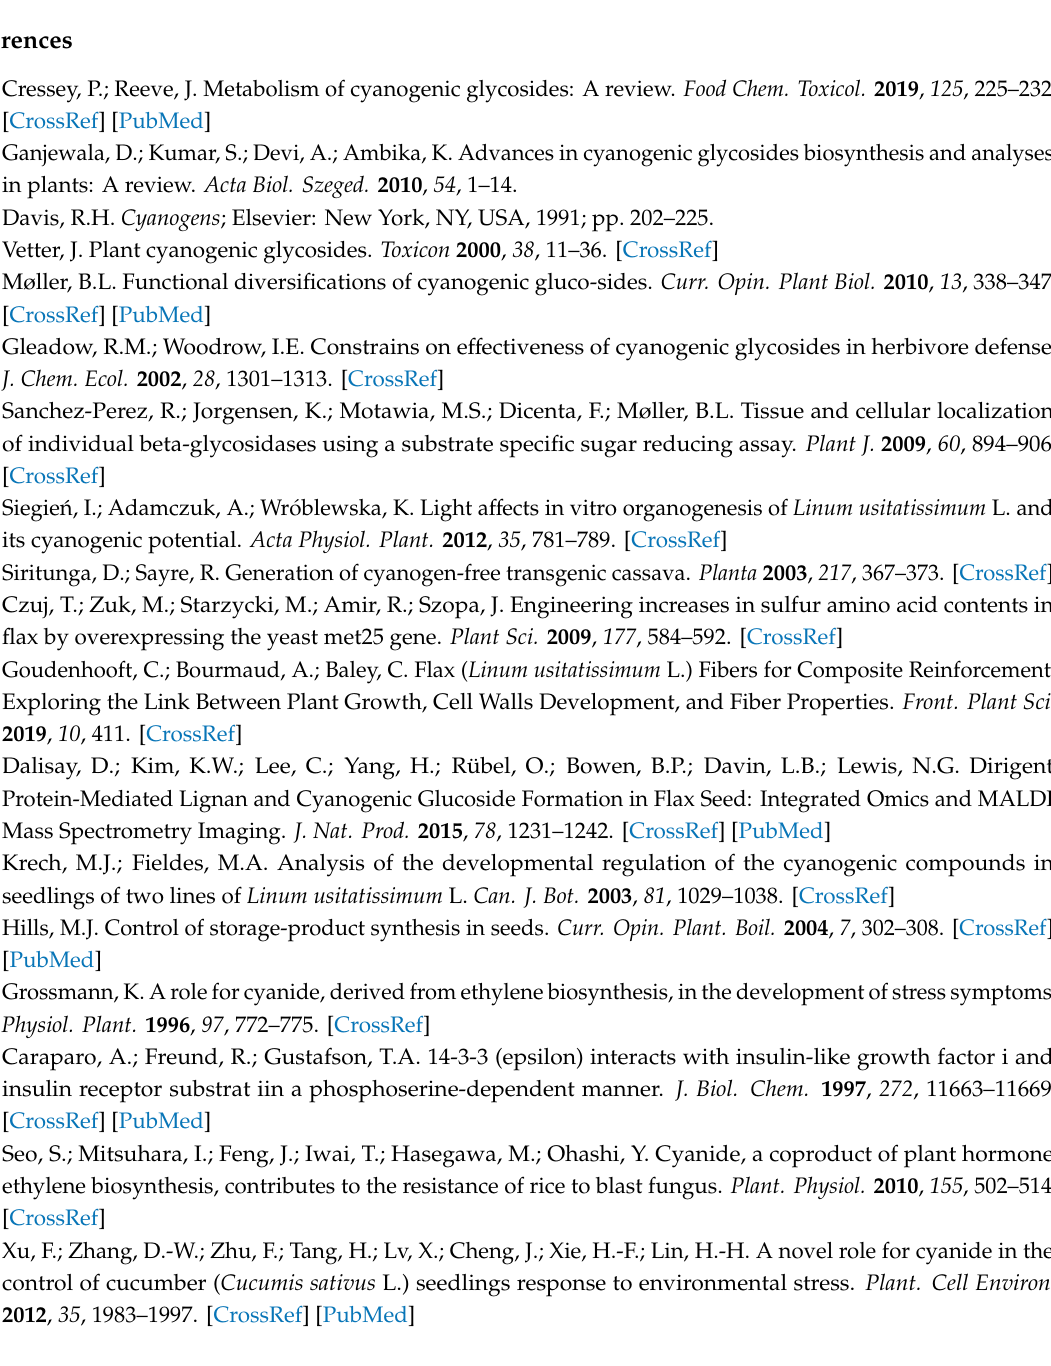
Table S1: Content of cyanogenic glycosides in flax tissues at successive stages of development of control plants (Linola) and those producing sulfur amino acids (Met25), Table S2: Activity of GC metabolism genes during plant growth in control and Met25 expressing plants, Table S3: Sequences of primers used in RT-PCR analysis. Figure S1: Schematic representation of changes in cyanogenic monoglucoside level and flavonoids content during development of flax